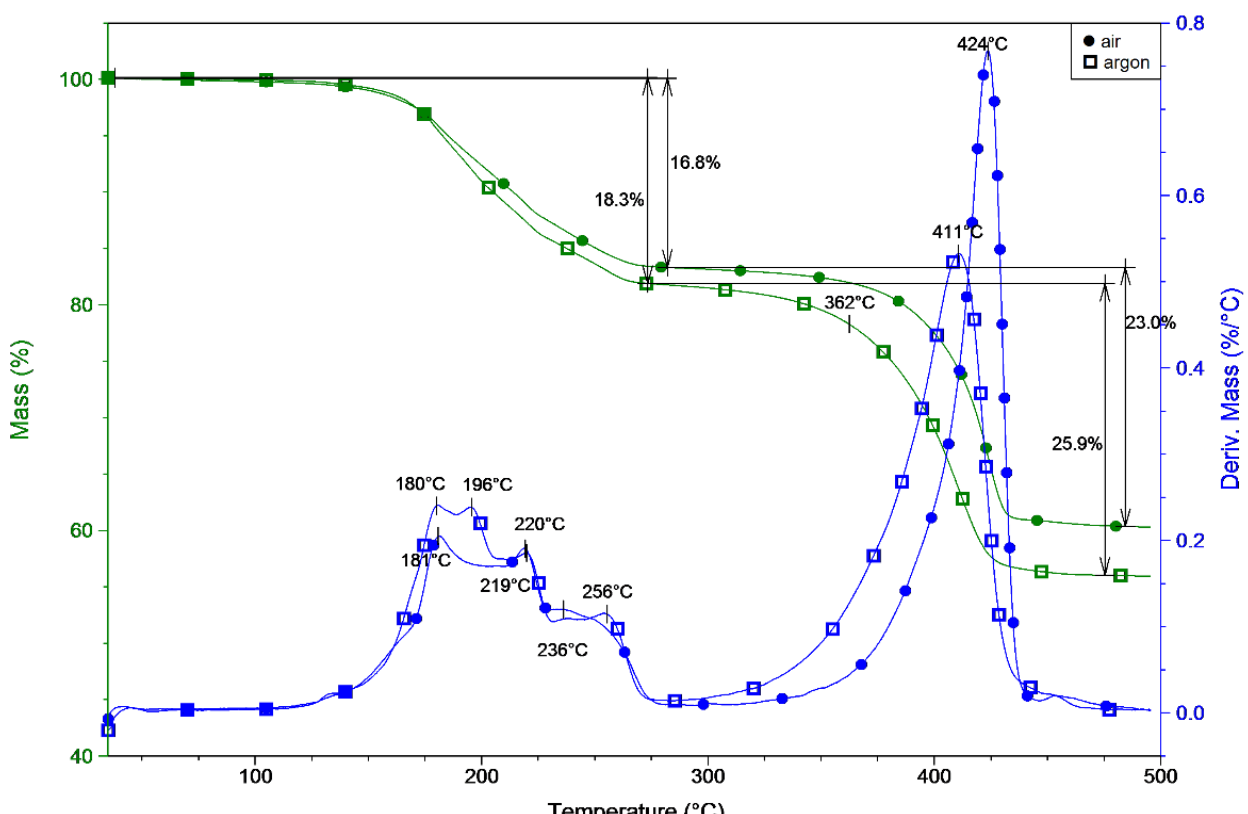
Figure 7. DTG curve of compound 1 in an inert ( □ ) and air (•) atmosphere.